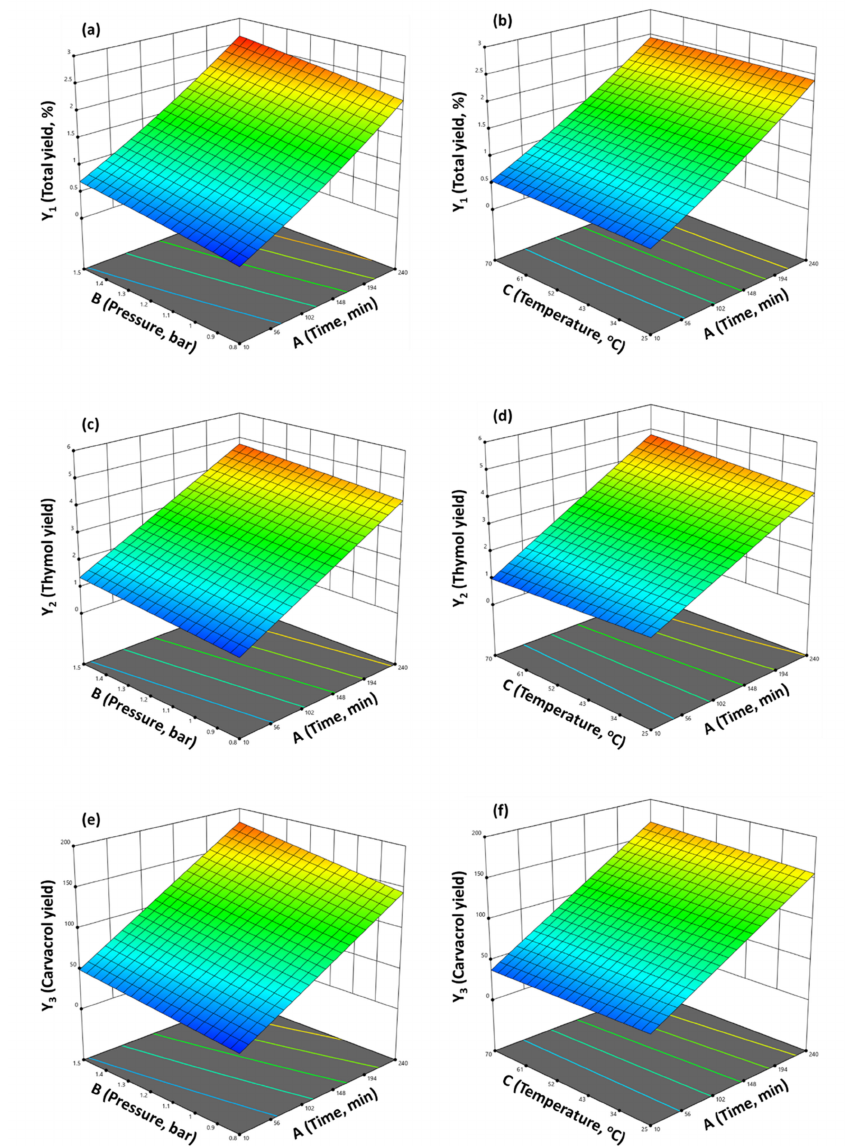
Figure 4. Response surfaces and contour plots for the employed CCD: ( a ) Y 1 response to AB interaction; ( b ) Y 1 response to AC interaction; ( c ) Y 2 response to AB interaction; ( d ) Y 2 response to AC interaction; ( e ) Y 3 response to AB interaction; ( f ) Y 3 response to AC